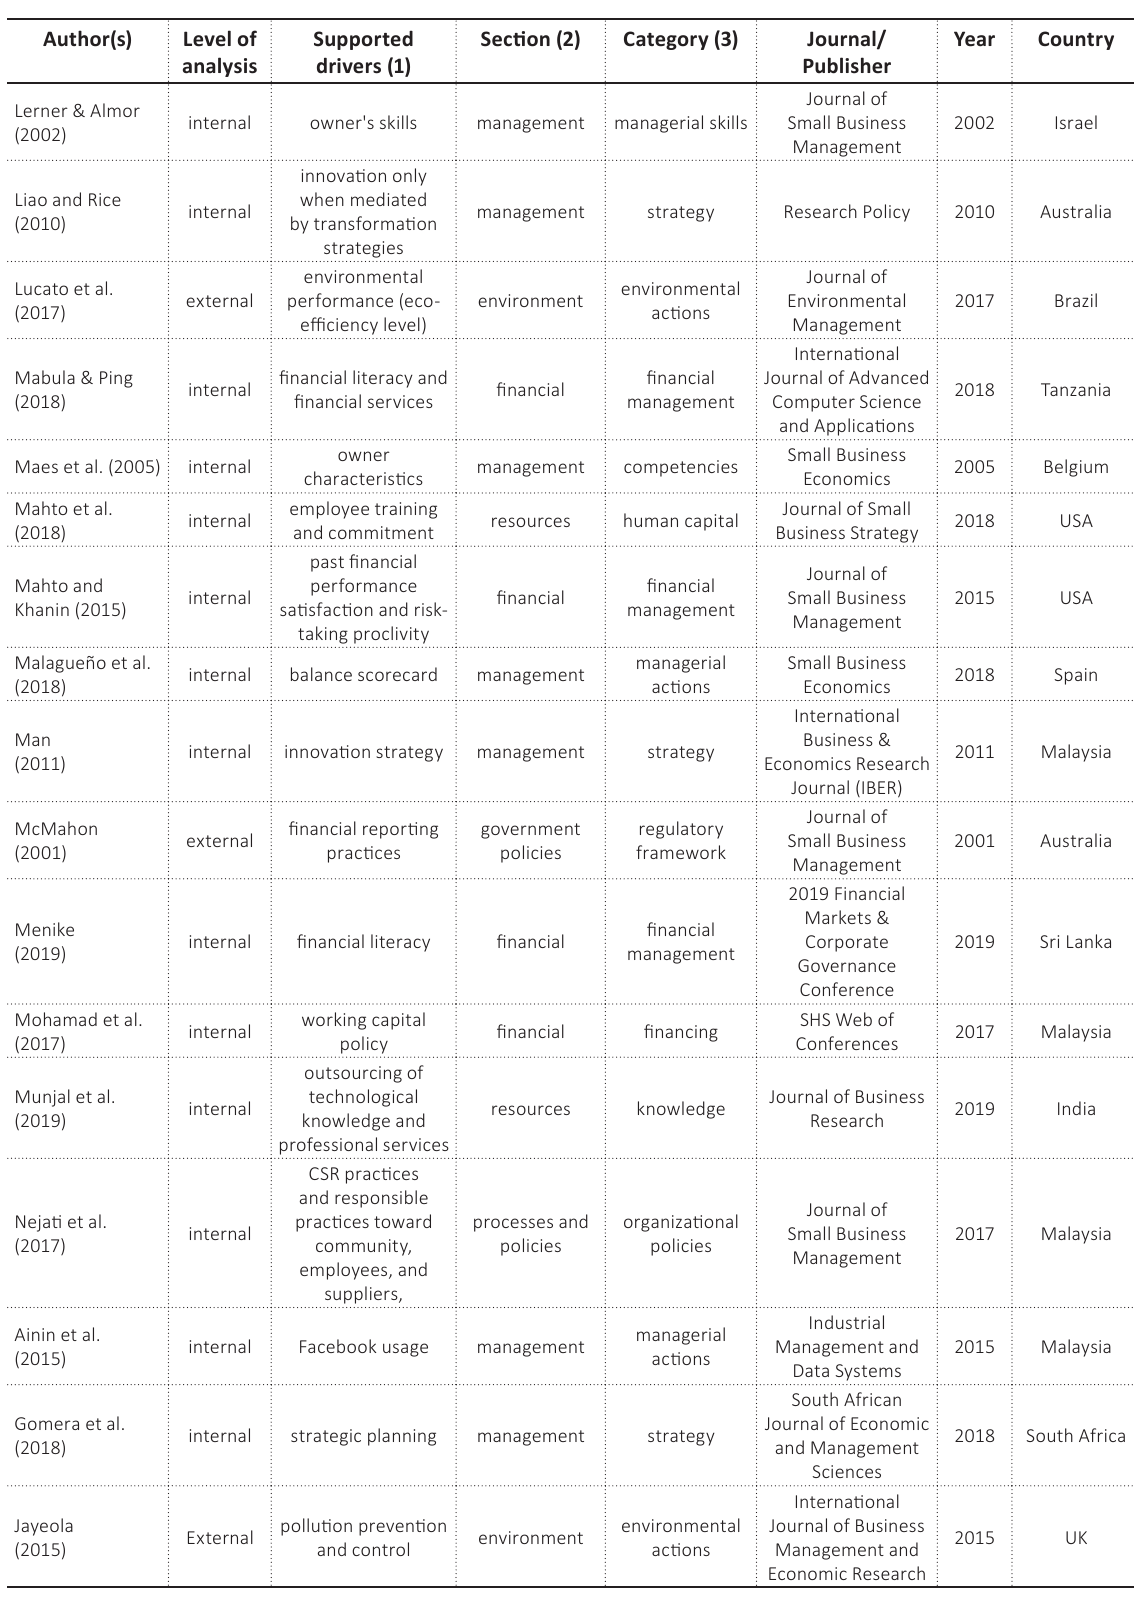
Table A1 (cont.). Full list of contingency